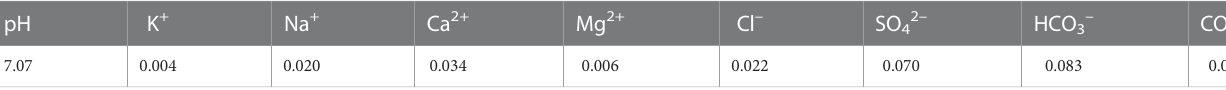
TABLE 2 Initial salt content and ion composition of soil. Depth Salinity (g/ (cm)